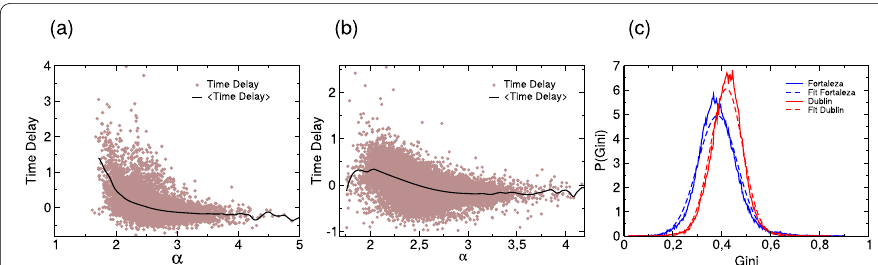
Figure 6 Characterization of all bus trips. In ( a ) we show, for each small circle, the relation between the fraction delay in function of the α exponent for Fortaleza. As we see, when α → 2.0 the average fraction delay, calculated by the Nadaraya–Watson (red dashed line), grows fast. In ( b ) the same is shown for Dublin. In ( c ) we show the probability distribution for the Gini for Fortaleza (in blue) and Dublin (in red). One can see that the PDFs appear Gaussians, despite a slight assimetry when compared to the statistical fit (in dashed lines). To confirm that hypothesis we apply the Kolmogorov–Smirnov test. It obtained p equals 0 for Fortaleza and Dublin. Therefore the hypothesis that the distribution is normal is rejected. The kurtosis and skewness [31] were also computed. The kurtosis for Fortaleza is 1.9493 and the skewness is 0.5485. For Dublin, the kurtosis is 1.450 and the skewness is –0.0282. These results indicates that, despite the fact that one visually appears the normal fit, the PDF of Fortaleza is more asymmetric than Dublin’s one